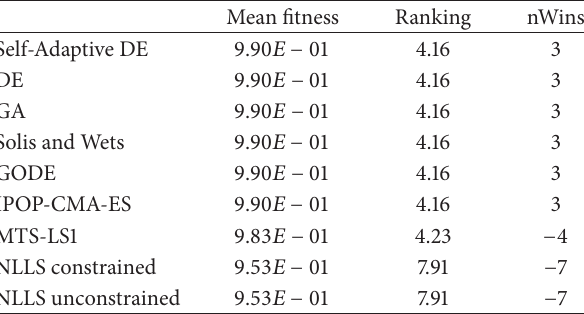
Table2:Meanfitness,averageranking,andnumberofwins(nWins) inpair-wisecomparisonswiththeotheralgorithmsontheglutamate concentration